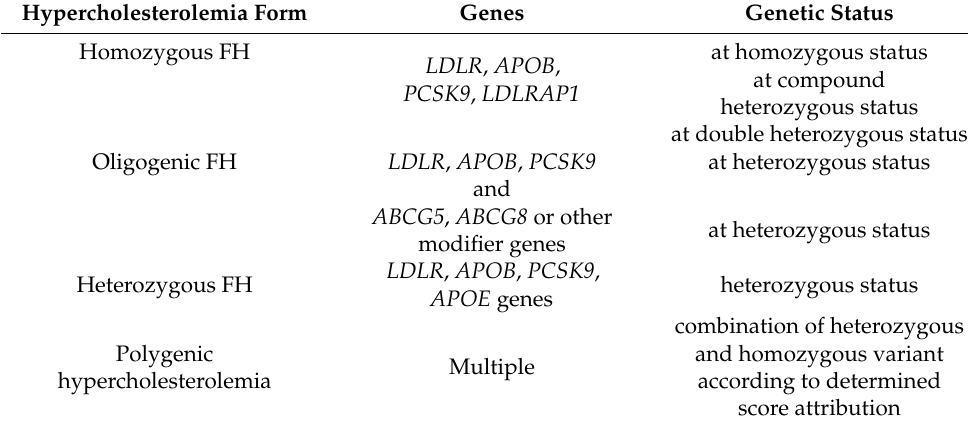
Table 1. Genetic status and different molecular alterations identified in the different forms of familial hypercholesterolemia. Hypercholesterolemia Form Genes Genetic